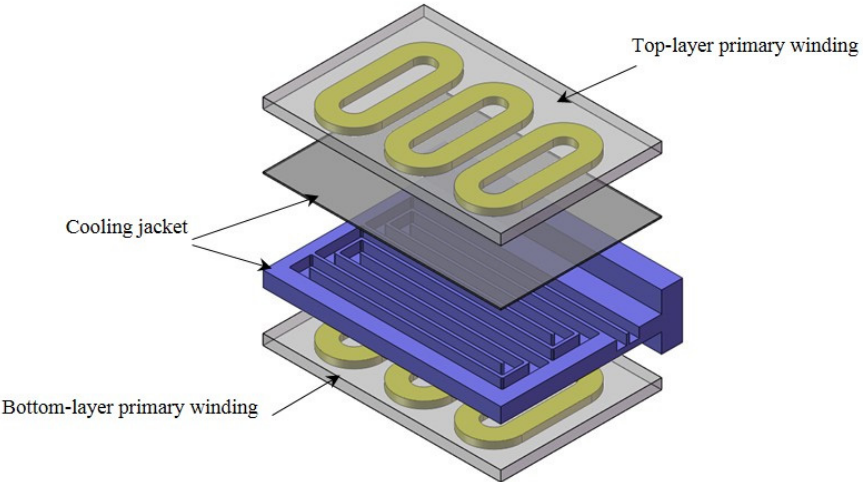
Figure 6. The cooling jacket with slots.